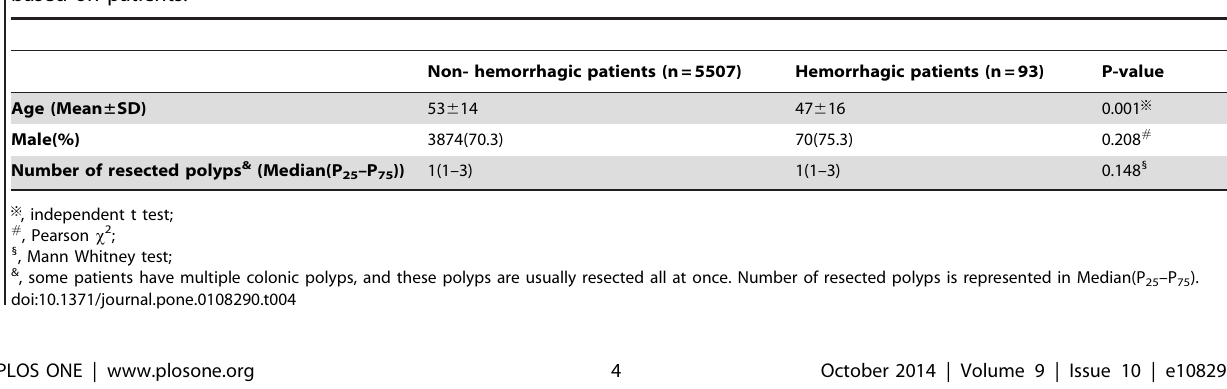
Table 3, multivariate logistic regression analysis indicated that polyp pathology was a significant risk factor (P =0.008). The odds ratio (OR) of the inflammatory/hyperplastic polyps was referenced